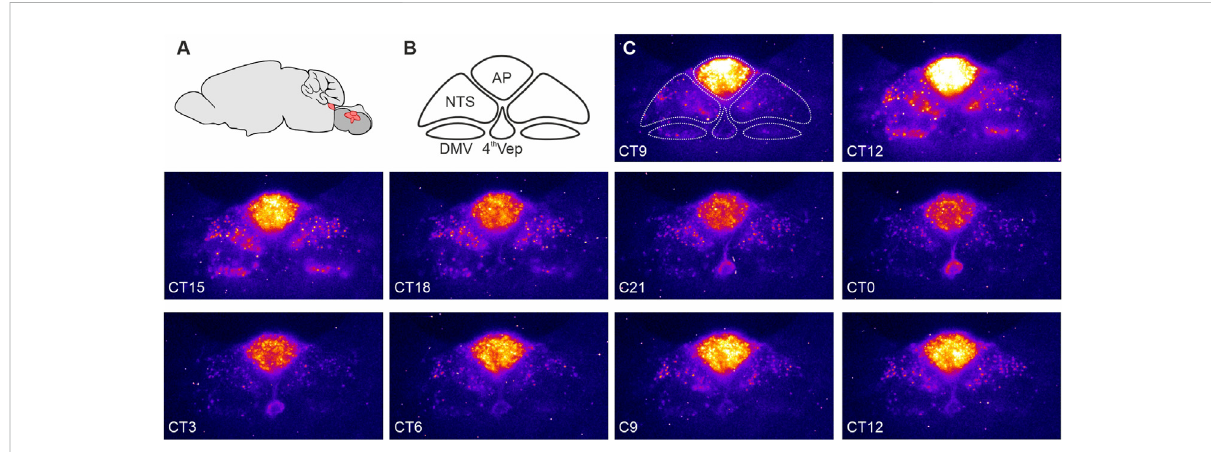
FIGURE 1 PERIOD2::LUCIFERASE (PER2::LUC) expression in the dorsal vagal complex (DVC). (A) Schematic representation of the mouse brain with the brainstem (red) sectioned coronally at the level of the DVC and rotated 90 ° to illustrate the anatomical location of the DVC. (B) Components of the DVC:theareapostrema(AP),nucleusofthesolitarytract(NTS),dorsalmotornucleusofthevagusnerve(DMV),andependymalcellsliningthefourth ventricle (4thVep). (C) Raw bioluminescence images with the DVC structures depicted in B overlayed the fi rst image. Coronal brain slices (250 um) were collected from 10 to 20 week old male PER2::LUC mice and cultured in an Olympus Luminoview LV200 (Olympus, Japan) equipped with a cooled Hamamatsu ImageEM C900-13 EM-CCD camera. Bright colours code high PER2::LUC expression. Note how the intensity and distribution of the bioluminescent signal changes between each consecutive images taken every 3 h. Unpublished example from Chrobok et